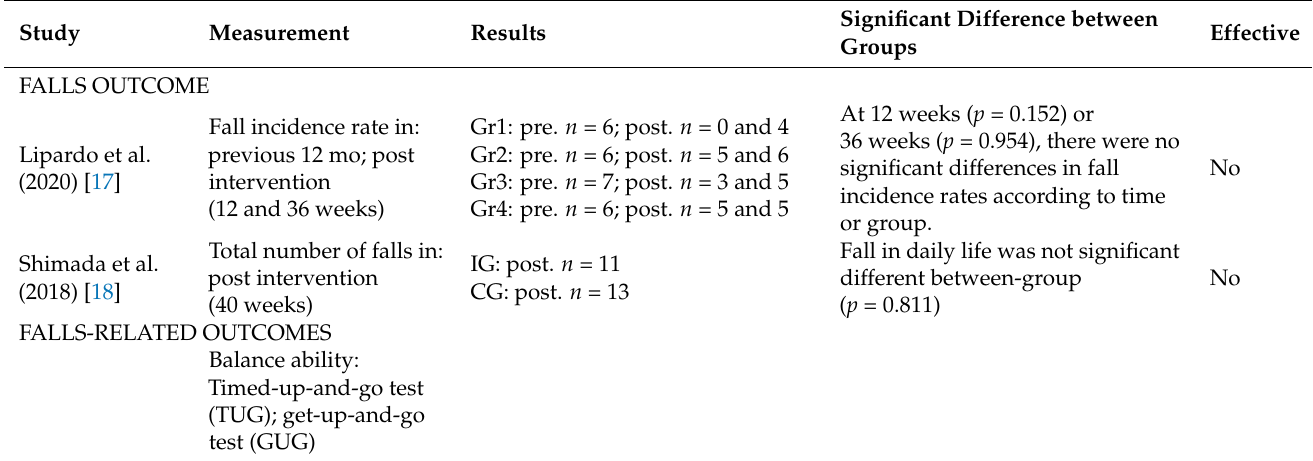
Table 3. Falls and falls-related outcome results and findings of statistical